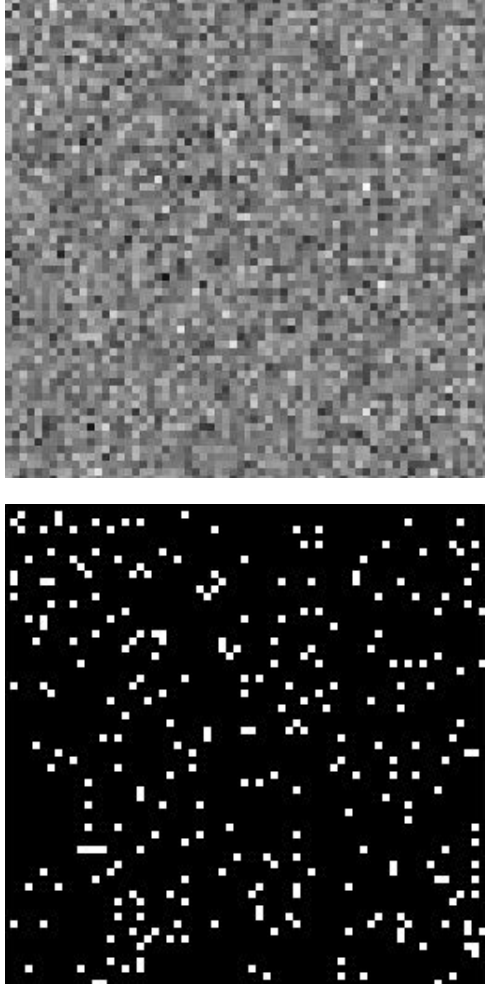
Figure 10. Binary image after high threshold level